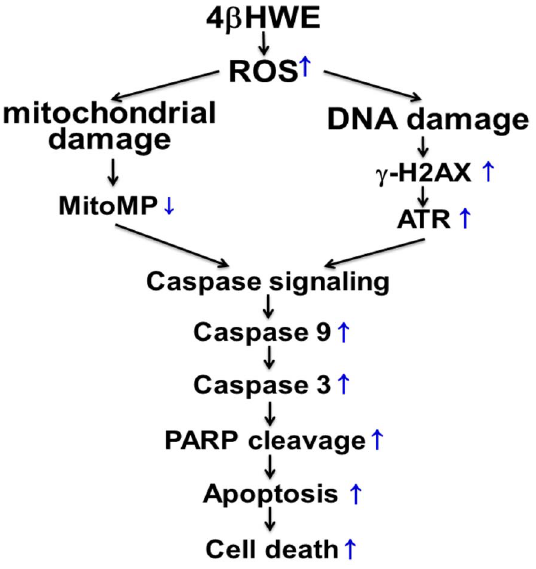
Figure 9. Schematic diagram of hypothesized mechanism of 4 b HWE-induced selective killing of human oral cancer Ca9-22 cells preferentially to normal oral HGF-1 cells. Changes in Ca9-22 cells are indicated by blue arrows. Normal oral cells (not shown) showed relatively smaller changes compared to Ca9-22 cells. In Ca9-22 treated with 4 b HWE, enhanced ROS generation resulted in increased oxidative stress. The induction of ROS then increased mitochondrial dysfunction and facilitated reduction of mitochondrial membrane potential in Ca9- 22 cells. Induction of ROS also resulted in increased DNA damage in Ca9-22 cells, e.g., c -H2AX in DSB, which then induced ATR phosphor- ylation. Together, mitochondrial damage signaling and DNA damage signaling resulted in increased apoptosis signaling, which then led to selective apoptosis and killing of Ca9-22 cells.